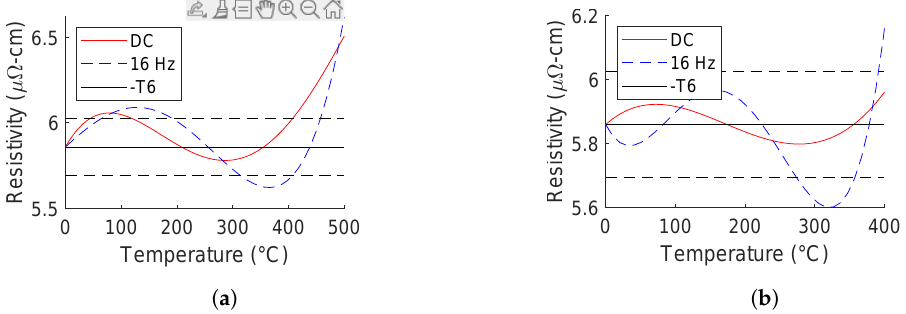
Figure 17. Trend line comparison for DC and 16 Hz tests; ( a ) Air-cooled, air-quenched, ( b ) air-cooled, water-quenched.